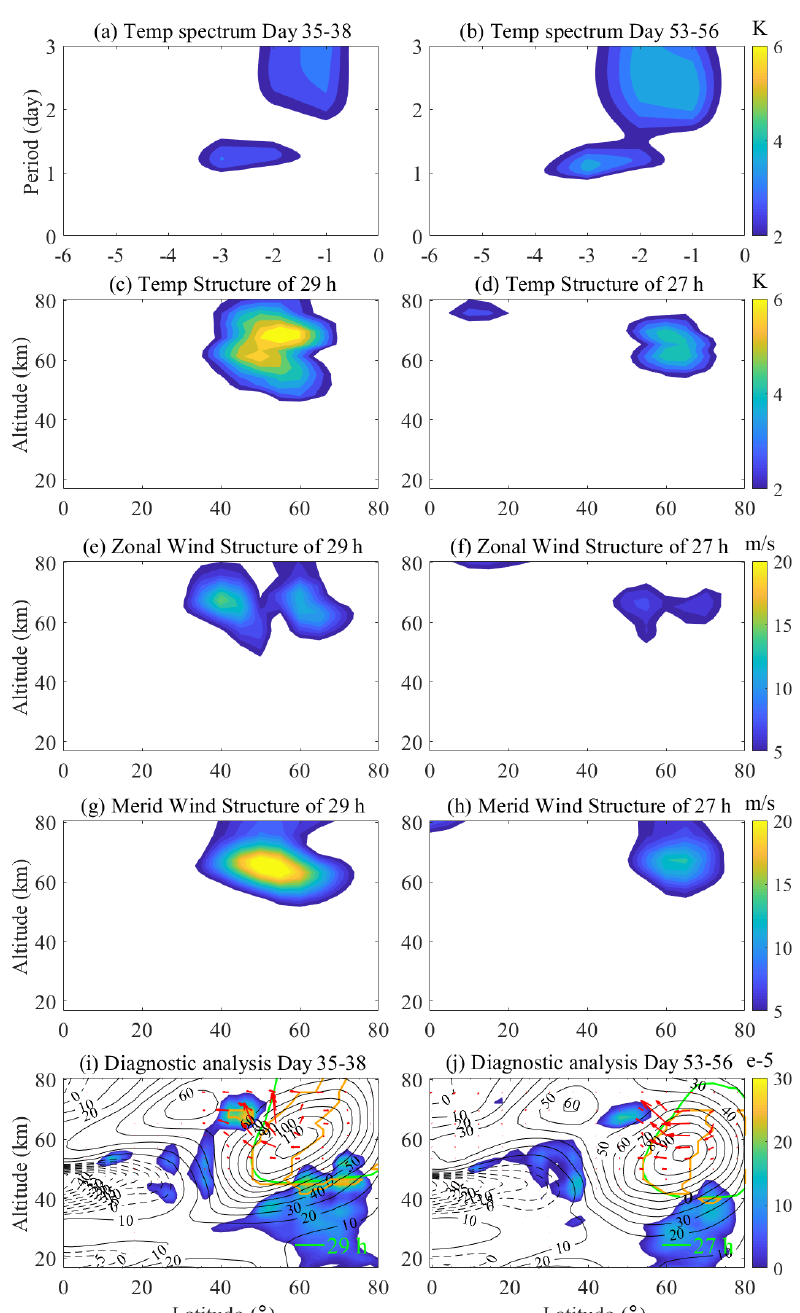
Figure 11. Same as Fig. 9 but for E3 during the 2019 boreal winter period.